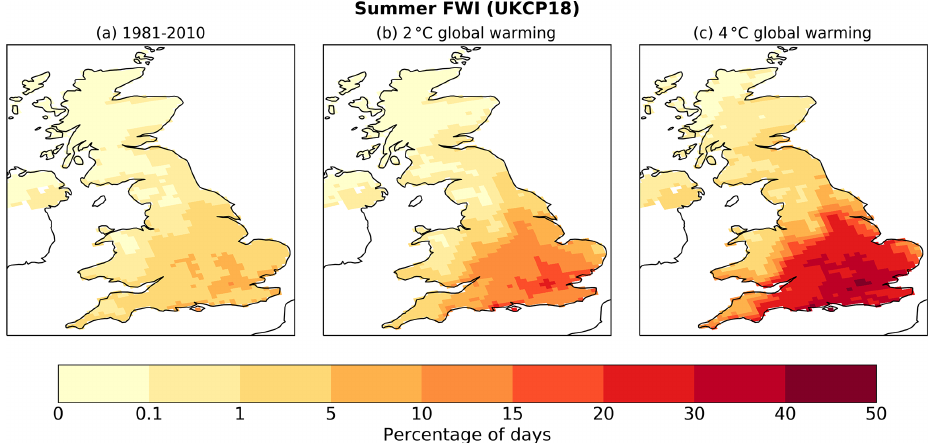
Figure 10. Percentage of summer days with very high fire danger (FWI > 17.35) over the UK, based on the UKCP18 12km data averaged over the 12 ensemble members. (a) Historical period (1981–2010), (b) 2 ◦ C global warming and (c) 4 ◦ C global warming. The colour bar is the same as in Fig.